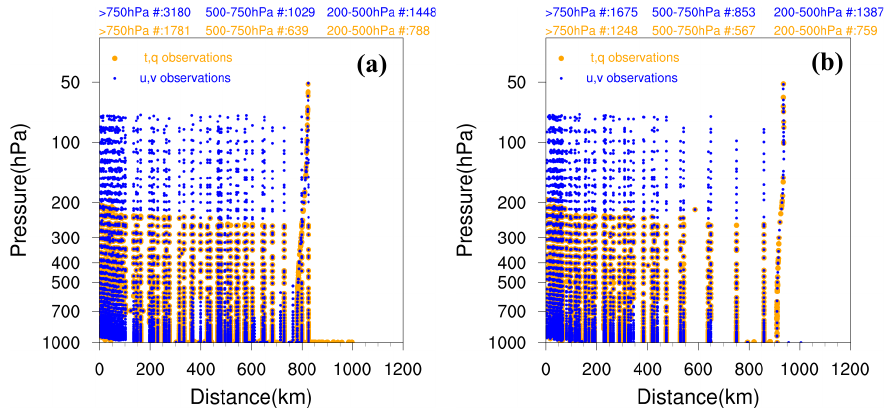
Figure 5. Vertical distribution of observations that are assimilated by Gridpoint Statistical Interpolation (GSI) for Hurricane Joaquin at ( a ) 1800 UTC 2 October 2015 and ( b ) 1800 UTC 3 October 2015. The large orange dots denote the temperature (t) and humidity (q) data; while the small blue dots represent wind data (u and v). The numbers of observations that are assimilated in three different levels (below 750 hPa, 500–750 hPa, and 200–500 hPa) are also shown on the top of ( a ) and ( b ). The x-axis represents the distance to the storm